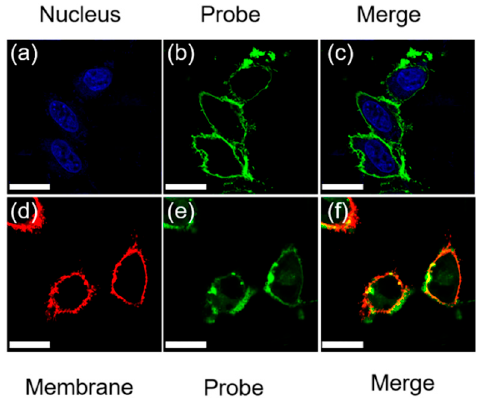
Figure 5. Fluorescence images of NDSA-L5, DAPI, DiI in Hep-G2 cancer cells. ( a ) Stained with DAPI (Nucleus); ( b ) stained with NDSA-L5 (Probe); ( c ) merge of ( a ) and ( b ); ( d ) stained with DiI (Membrane); ( e ) stained with NDSA-L5 (Probe); ( f ) merge of ( d ) and ( e ). Scale bar: 20 µm.